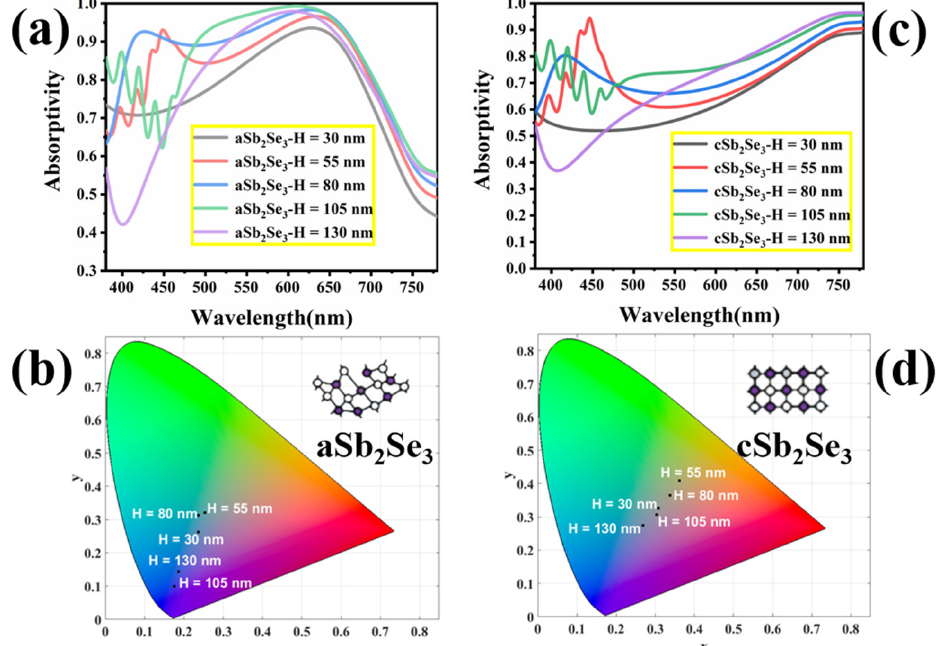
Figure 9. Absorption spectra ( a ) and corresponding chromaticity diagram coordinates ( b ) for different structural parameters ( H ) under the amorphous state; absorption spectra ( c ) and corresponding chromaticity diagram coordinates ( d ) for different structural parameters ( H ) under the crystalline state.